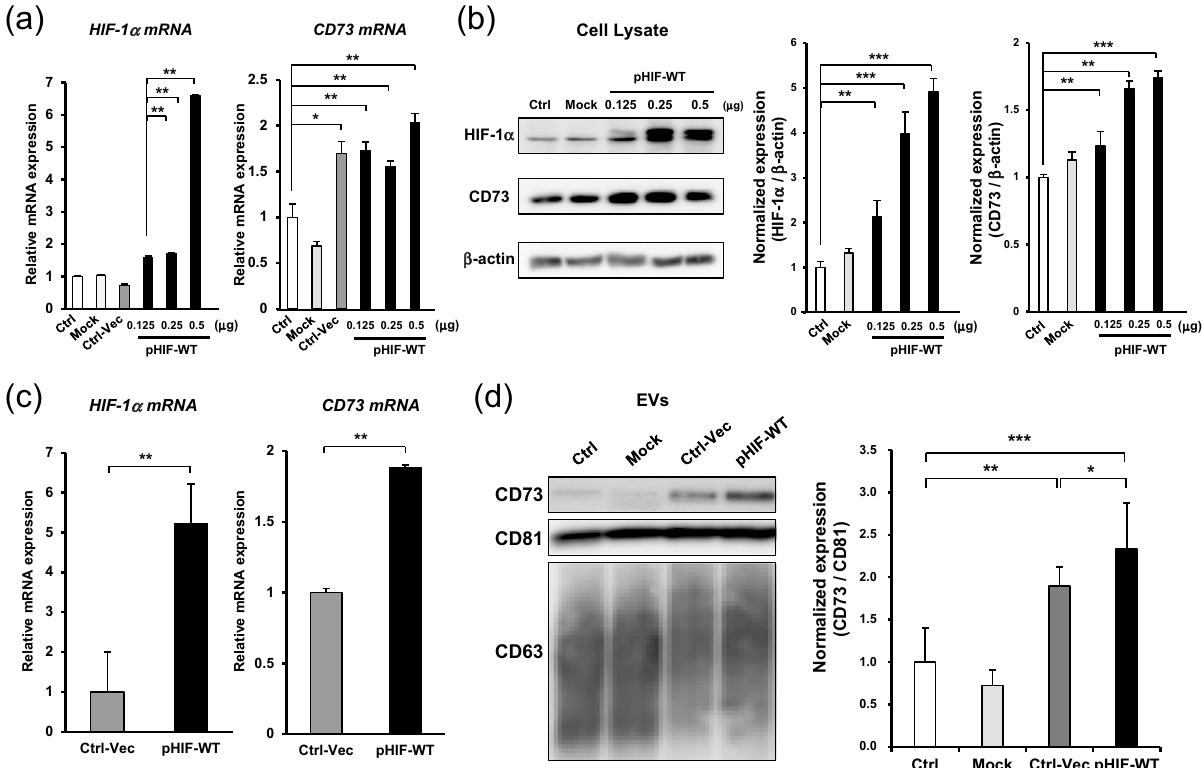
Figure 3. HIF-α regulates the expression of CD73 in GMSCs. ( a , b ) Effect of HIF-1α-overexpression on cellular CD73 expression in GMSCs. GMSCs were seeded on 6-well plates (5 × 10 5 cells/well) a day before transfection. At approximately 60–70% confluence, the cells were transfected with indicated amounts of HIF-1α-overexpressed plasmid (pHIF-WT) (0.125, 0.25, and 0.5 μg/2 mL) for 24 h. The mRNA and protein expression of HIF-1a and CD73 in GMSC was analyzed by quantitative real-time PCR ( a ) and western blot analysis ( b ). Relative HIF-1α and CD73 protein expressions were measured by quantifying the density of bands and normalized against β-actin using the MultiGauge software (right). After transfection of pHIF-WT (0.25 µg/2 mL) for 48 h ( c ), GMSC-derived EVs were isolated from culture media, and the expression of CD73 in EVs was evaluated by western blotting ( d ). Exosome-associated CD63 and CD81 proteins were used as loading controls. Relative CD73 protein expressions were measured by quantifying the density of bands and normalized against CD81 using the MultiGauge software ( d ; right). * P < 0.05; ** P < 0.01; *** P < 0.001. Error bars are means ± SD., n = 3. Data represent mean ± SD. The significance of differences between groups was determined by one-way Tukey’s test. Full blots are presented in Supplementary